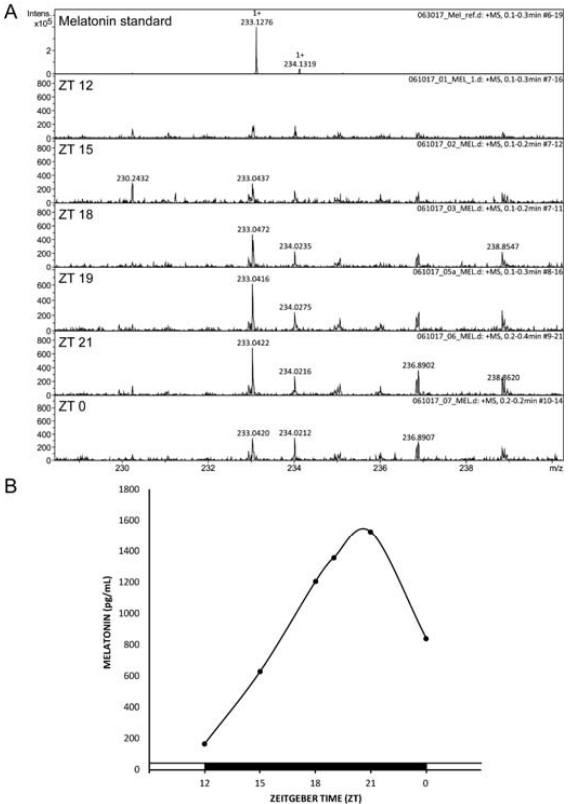
Figure 1. Swiss Webster mice serum melatonin levels through the dark phase. ( A ) DIESI/MS mass spectra diagrams of melatonin at different zeitgeber times (ZT). ( B ) Melatonin levels at ZT12, ZT15, ZT18, ZT19, ZT21, and ZT0. Data are derived from one mouse for each ZT.